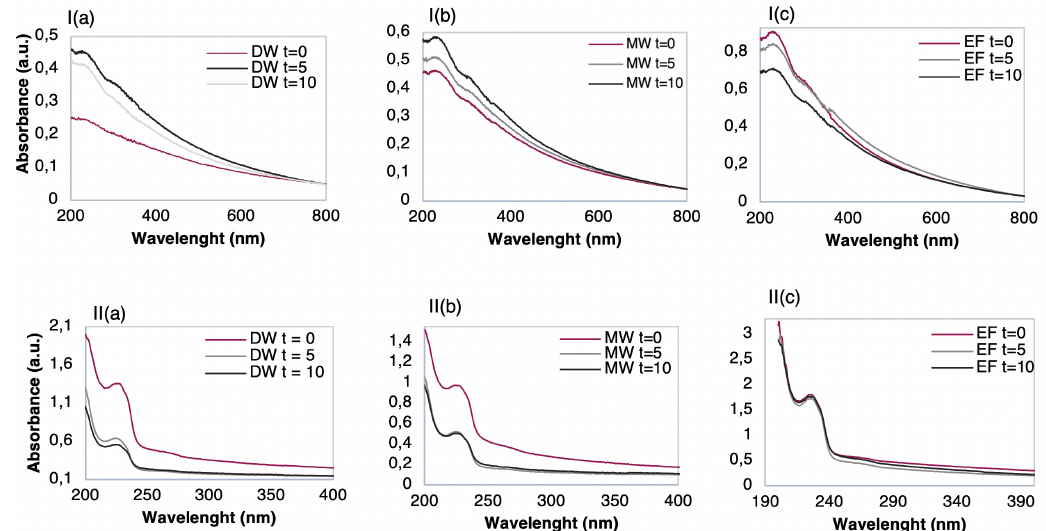
Figure 6. UV-Vis spectra of ( I ) (PAH / GO) 5 films and ( II ) (PEI / PSS) 5 before and after immersions times (t = 0, 5, and 10 min) in 10 − 9 M TCS solutions of: ( a ) DW; ( b ) MW, and ( c ) EF.